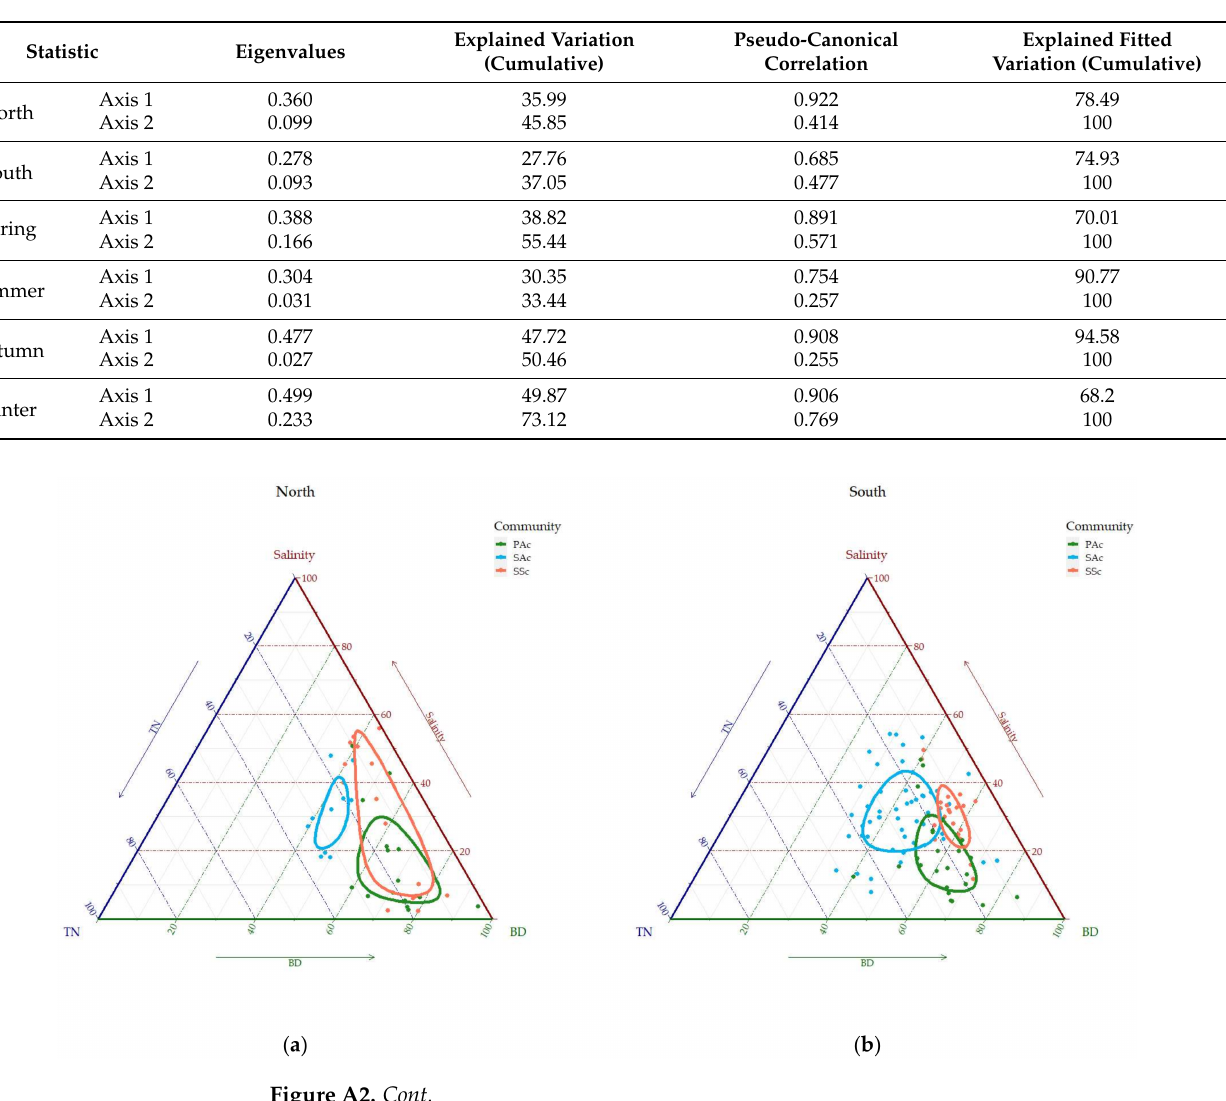
Table A3. Eigen values and correlation coefficients of communities and environmental factors on the first two axes of RDA.